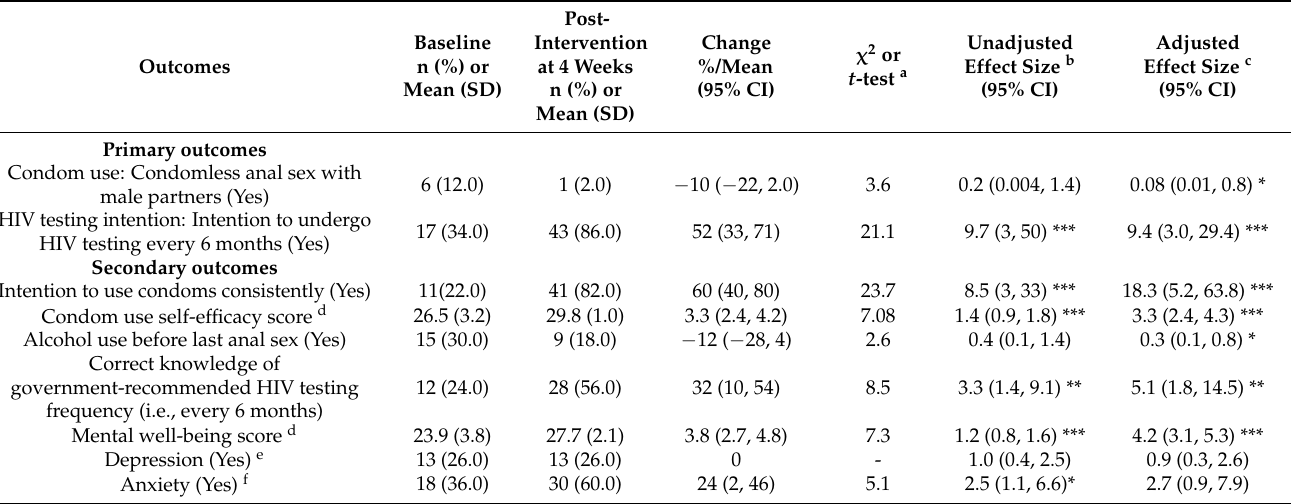
Table 4. Outcome evaluation of Sakhi , a 3-week smartphone-delivered pilot online HIV prevention intervention among transgender women (n =